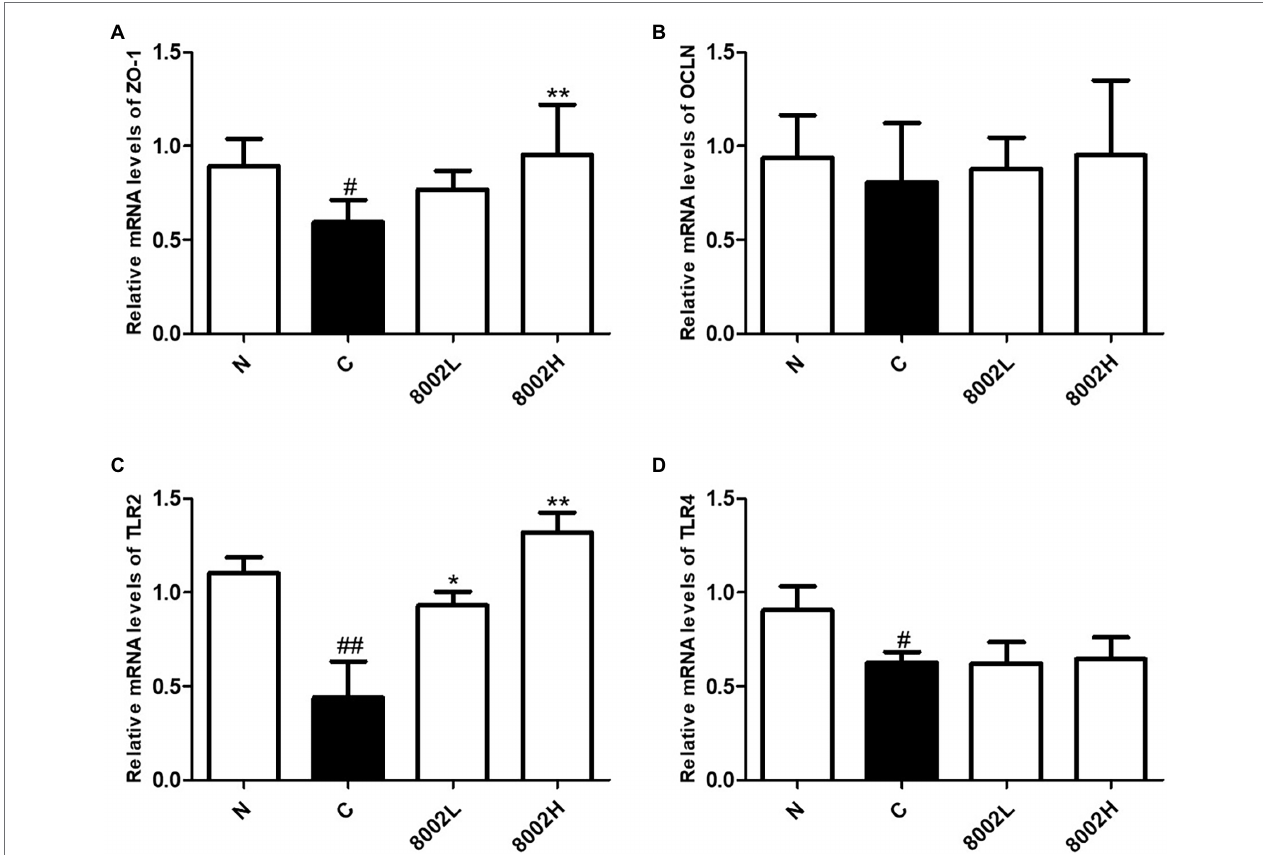
FIGURE 8 | The mRNA levels of (A) ZO-1, (B) occludin, (C) TLR2, and (D) TLR4 in small intestine. Data are represented as mean ± SEM. * p < 0.05 and ** p < 0.01 compared with kanamycin-treated control groups. # p < 0.01 and ## p < 0.01 compared with normal groups. N, normal group ( n = 8); C, kanamycin administration group ( n = 8); 8002L, kanamycin with 1.0 × 10 8 CFU/kg/day HY8002 administration group ( n = 8); 8002H, kanamycin with 1.0 × 10 9 CFU/kg/day HY8002 administration group ( n =